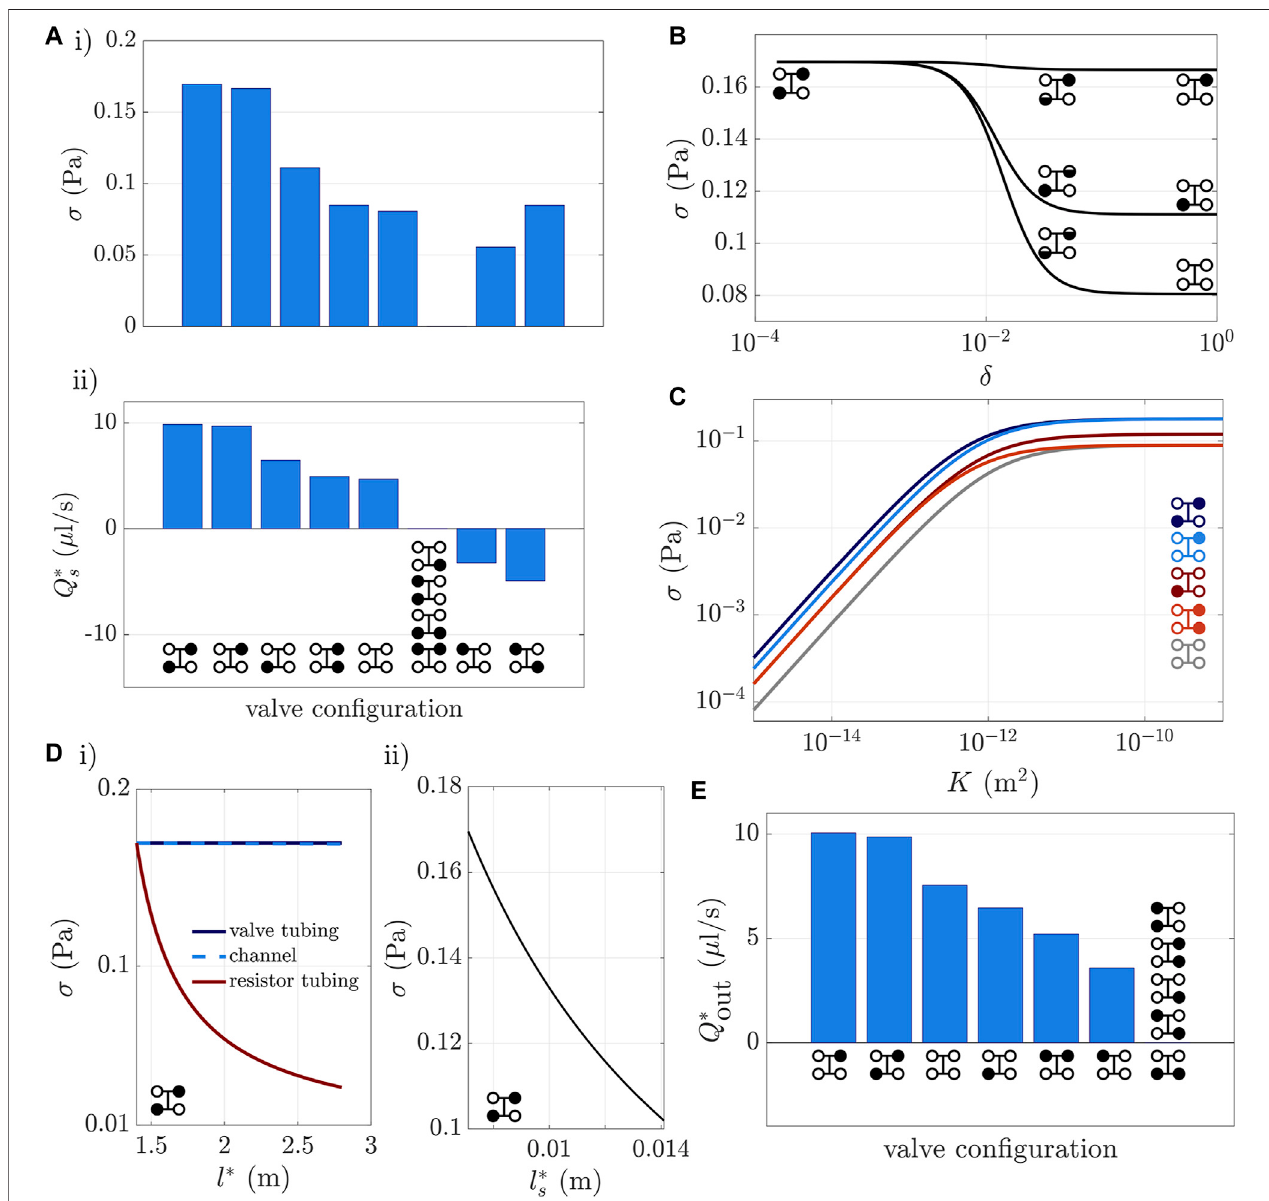
FIGURE5| Trendsin fl uxesandshearstressforstaticvalves. (Ai) Averagescaffoldshearstressand (Aii) scaffold fl uxunderdifferentstaticvalvecon fi gurationswith two,three,orfourvalvesopen.Thediagram(s)underthebarsin (Aii) showwhichvalvesareopen(white)orclosed(black).Thesixthcolumnshave | Q s * | < 0 . 0011 μ l/s,and σ < 4 × 10 – 5 Pa, i.e., small compared to the other columns. (B) Changes in shear stress when varying the fraction δ of a valve that is open. The diagrams indicate which valvesarebeingopened.Theeffectof (C) scaffoldpermeability, K ,and (D) tubesystemlength, l *,onscaffoldshearstress, σ .Thetubesystemlengthismadelonger vialengtheningeitherofthe (i) valvetubing,resistor,channels,or (ii) scaffoldandadjoiningchannels.Theshearstresscorrespondstothemaximisingstaticcon fi guration with open upper inlet and lower outlet, and closed upper outlet and lower inlet. (E) Flux out of the lower outlet, for static con fi gurations with 2, 3, or 4 valves open. Parameters are in Table 1